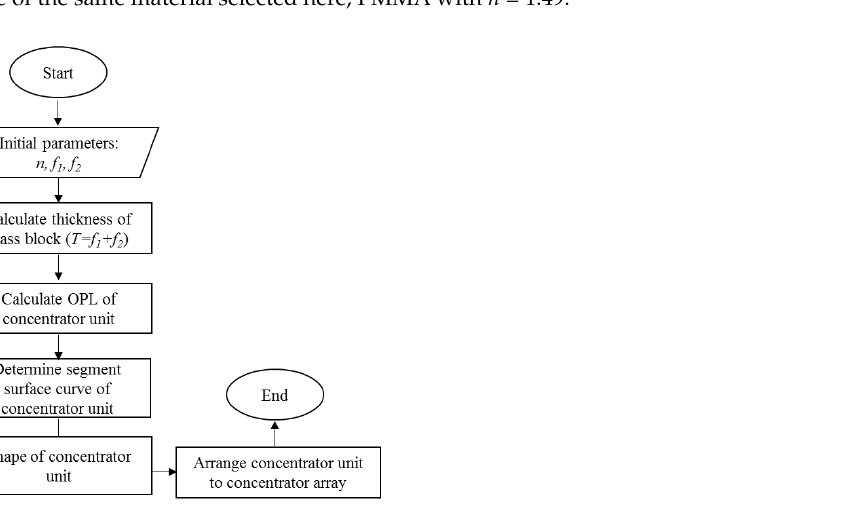
Figure 3. A view of lateral cross-section and ray diagram of the dual-lens concentrator unit to collimate and concentrate a parallel beam in the principle of conservation of optical path. Structural parameters of this typical concentrator unit: two aspherical lenses have sizes and focal lengths of s 1 , made of the same material selected here, PMMA with n = 1.49.